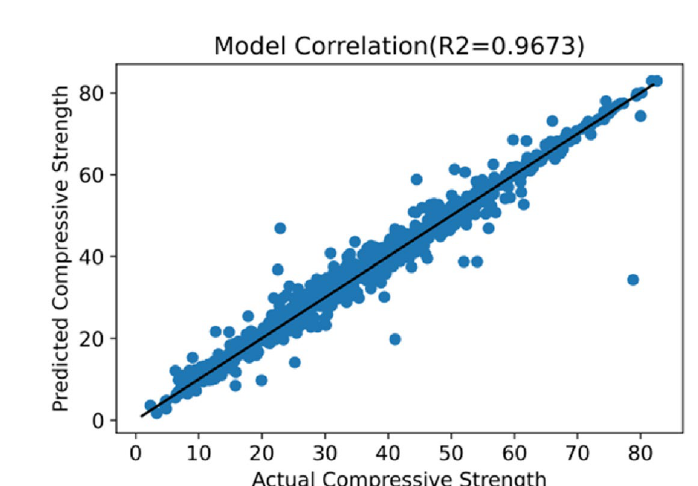
Fig. 14 Actual vs predicted for the concrete compressive strength ANN model (initial